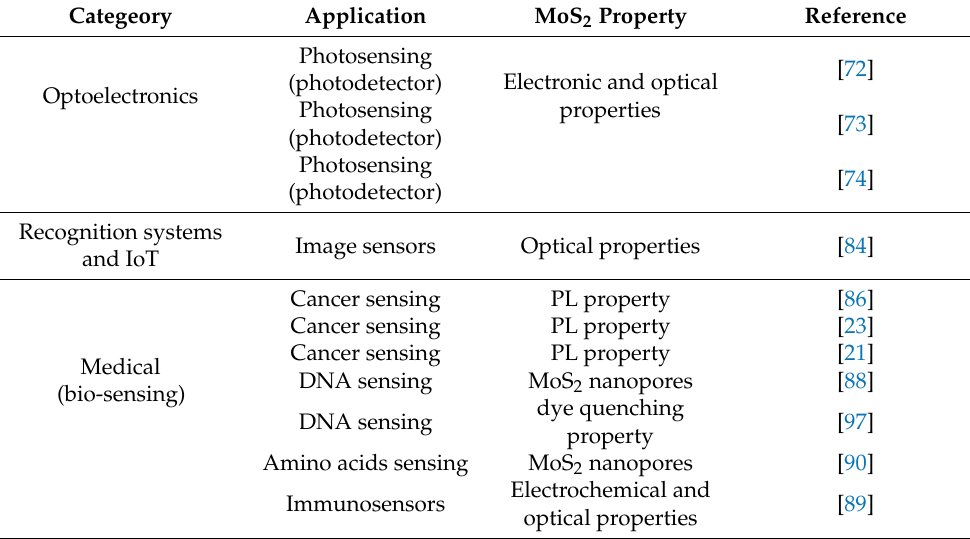
Figure 6. Illustrative diagram of different sensing applications of MoS 2 . Enhanced plasmonic resonance array [101], DNA sensing using MoS 2 nanopores [88,102], photodetector for biomedical imaging [72], refractive index sensing [100], gas sensing FET [103], Electrochemical biosensor for measuring cortisol in human sweat [104]. Table 4. Summary of sensing